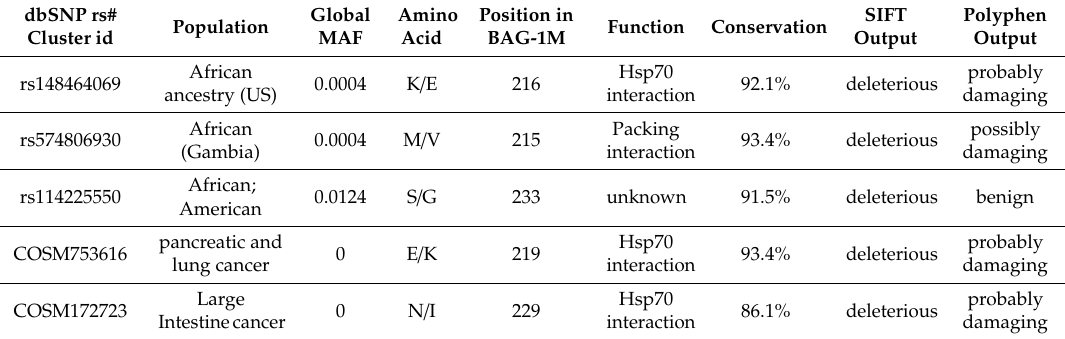
Table 5. Properties of the selected amino acids used for functional